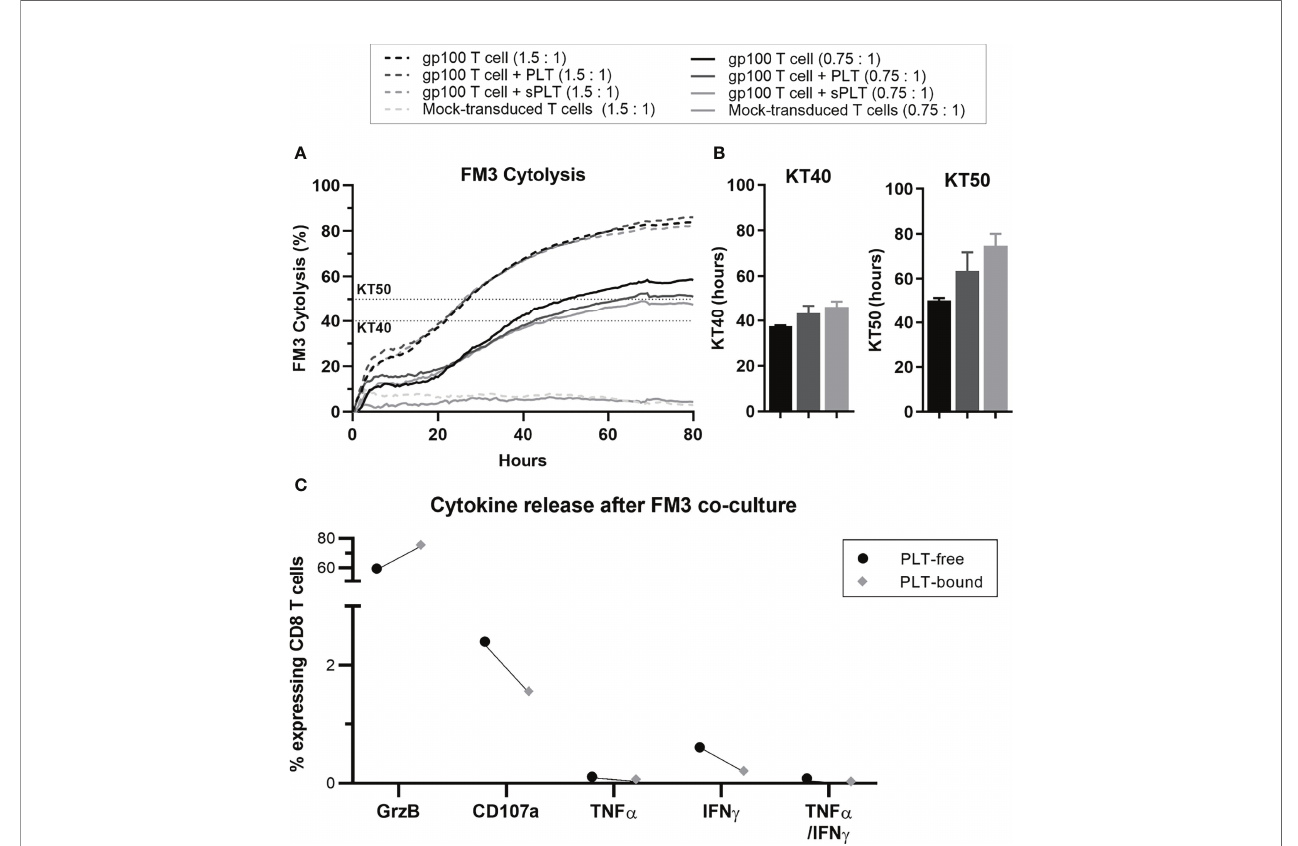
FIGURE 6 | After prolonged PLT exposure, in vitro PLT-bound CD8 T cells show impaired killing capacity compared to PLT-free CD8 T cells. Gp100-transduced T cells were co-cultured with PLT (ratio 100:1) or PLT-supernatant (sPLT) for 1h, after which unbound PLT were washed off. (A) The xCELLigence system was used to evaluate FM3 cytolysis after co-culture with transduced T cells alone (GP100 + T cells, green), transduced T cells + PLT (GP100 + T cells + PLT, red) or transduced T cells + PLT-supernatant (GP100 + T cells + sPLT, blue) at an effector to target ratio of 1.5: 1 (dotted lines) or 0.75:1 (full lines), for 80 hours (N = 1). (B) Killing time 40 (KT40) and 50 (KT50) ( i.e. , hours until 40% or 50% FM3 cells were killed, respectively) was calculated for all conditions at a ratio of 0.75:1. (C) PLT were co-cultured with Gp100-transduced T cells for 48 hours, followed by a 48-hour co-culture with FM3 cell line. The cytokine release of interferon-gamma (IFN- g ), tumor necrosis factor-alpha (TNF- a ) and Granzyme B (GrzB), as well as CD107a were compared in PLT-free and PLT-bound CD8 T cells (n = 1). Due to the small sample size statistical analyses were not performed (N =